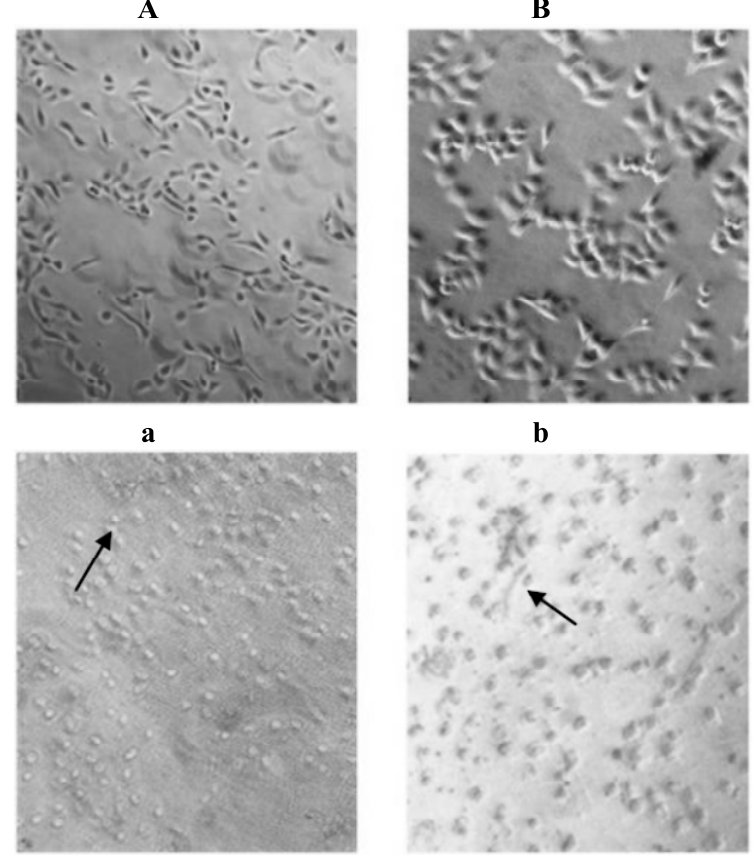
Figure 5. Morphological changes observed in different cell lines upon treatment with isolated PEs at IC concentration ( a – b ) after 24 h incubation examined by light 50 microscopy at 200× magnification. MCF-7( A , a ), HeLa ( B , b ). The arrows show the apoptotic bodies and destructed